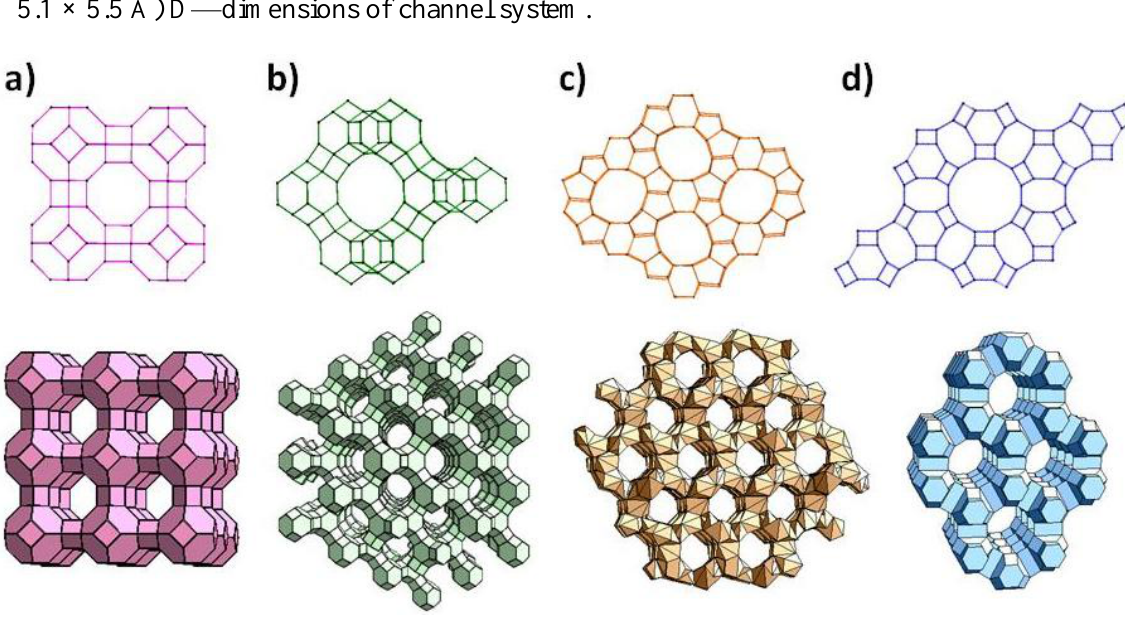
Figure 1. Representative zeolite frameworks, (with pore openings). ( a ) zeolite A (3D, 4.2 Å); ( b ) zeolite Y (3D, 7.4 Å); ( c ) Zeolite L (1D, 7.1 Å); ( d ) ZSM-5 (silicalite) (2D, 5.3 × 5.6 Å, 5.1 × 5.5 Å) D—dimensions of channel